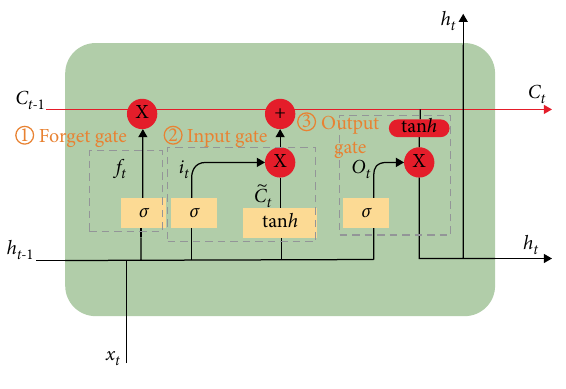
Figure 1: The structure of LSTM memory cell. Table 1: The symbol meanings of LSTM algorithm